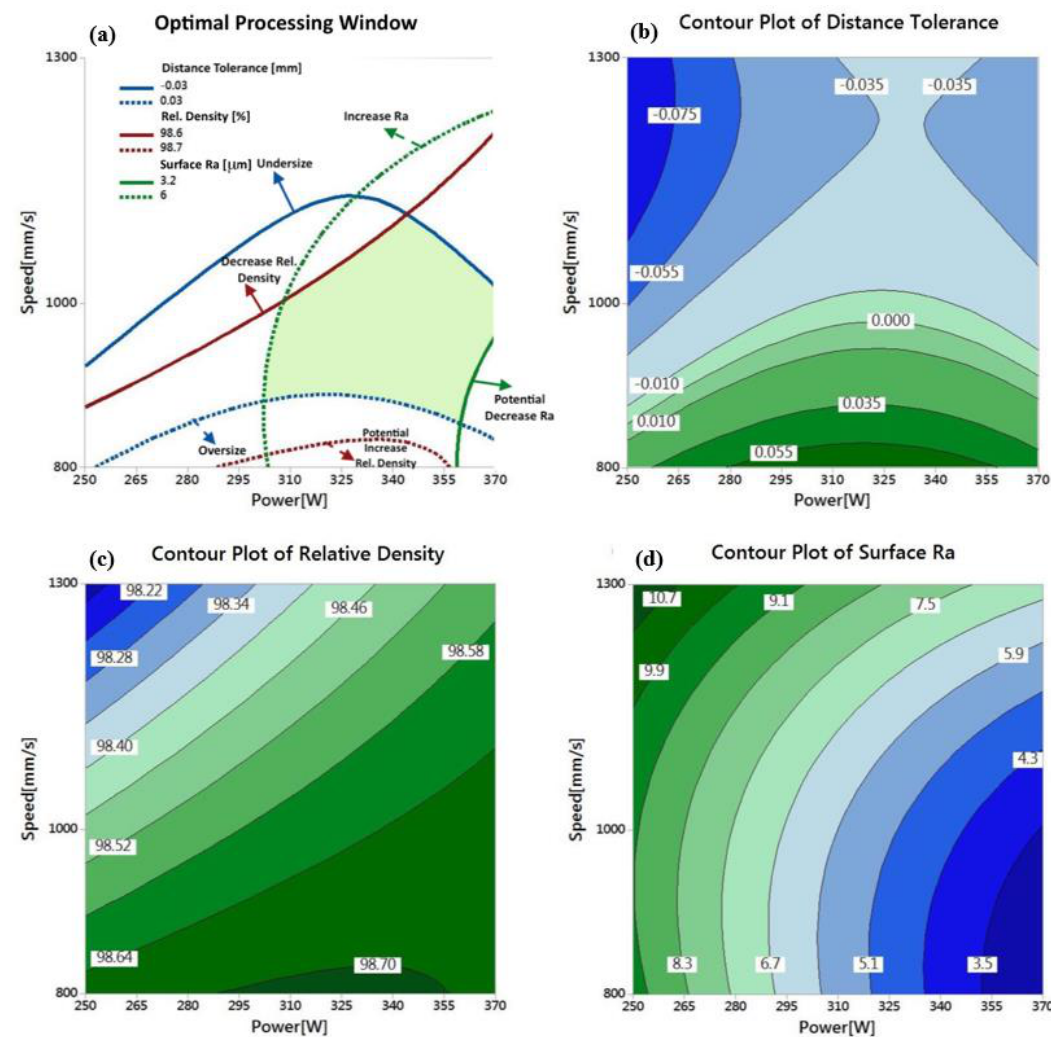
Figure 19. ( a ) Optimal processing window generated for the Al6061 alloy at the hatch spacing value of 0.15 mm and the effect of laser power (W) and scan speed (mm/s) on ( b ) distance tolerance (mm), ( c ) relative density (%) and ( d ) surface roughness Ra ( µ